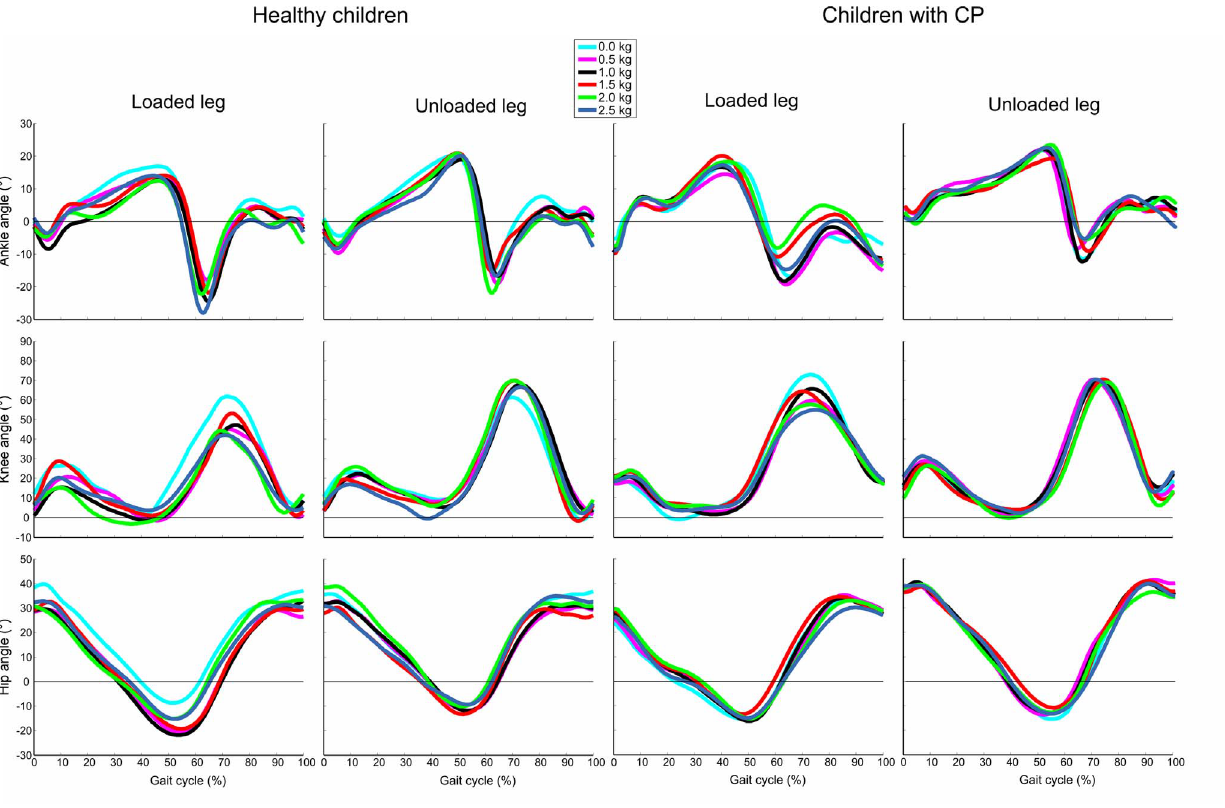
Figure 2. Hip, knee and ankle angle time histories. Time-normalized plot of hip, knee and ankle angles collected from a representative healthy child and a representative child with CP for the six trial conditions (see legend inside the figure). The angle trends are reported for UL and LL.